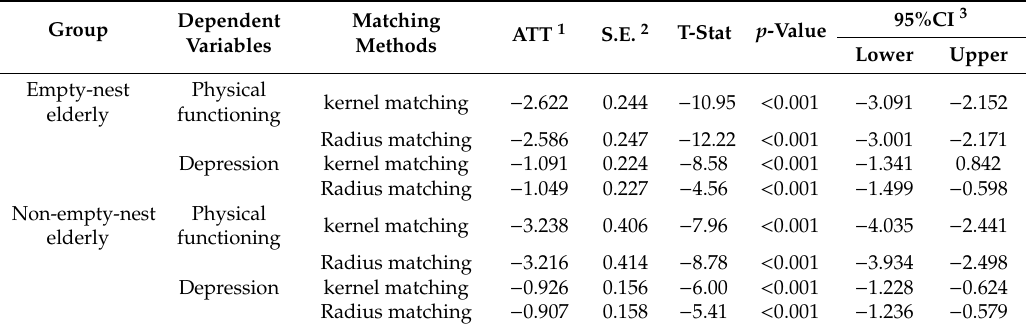
Table 4. Estimating the e ff ect of SP on the physical functioning and depression of empty-nest elderly using the PSM